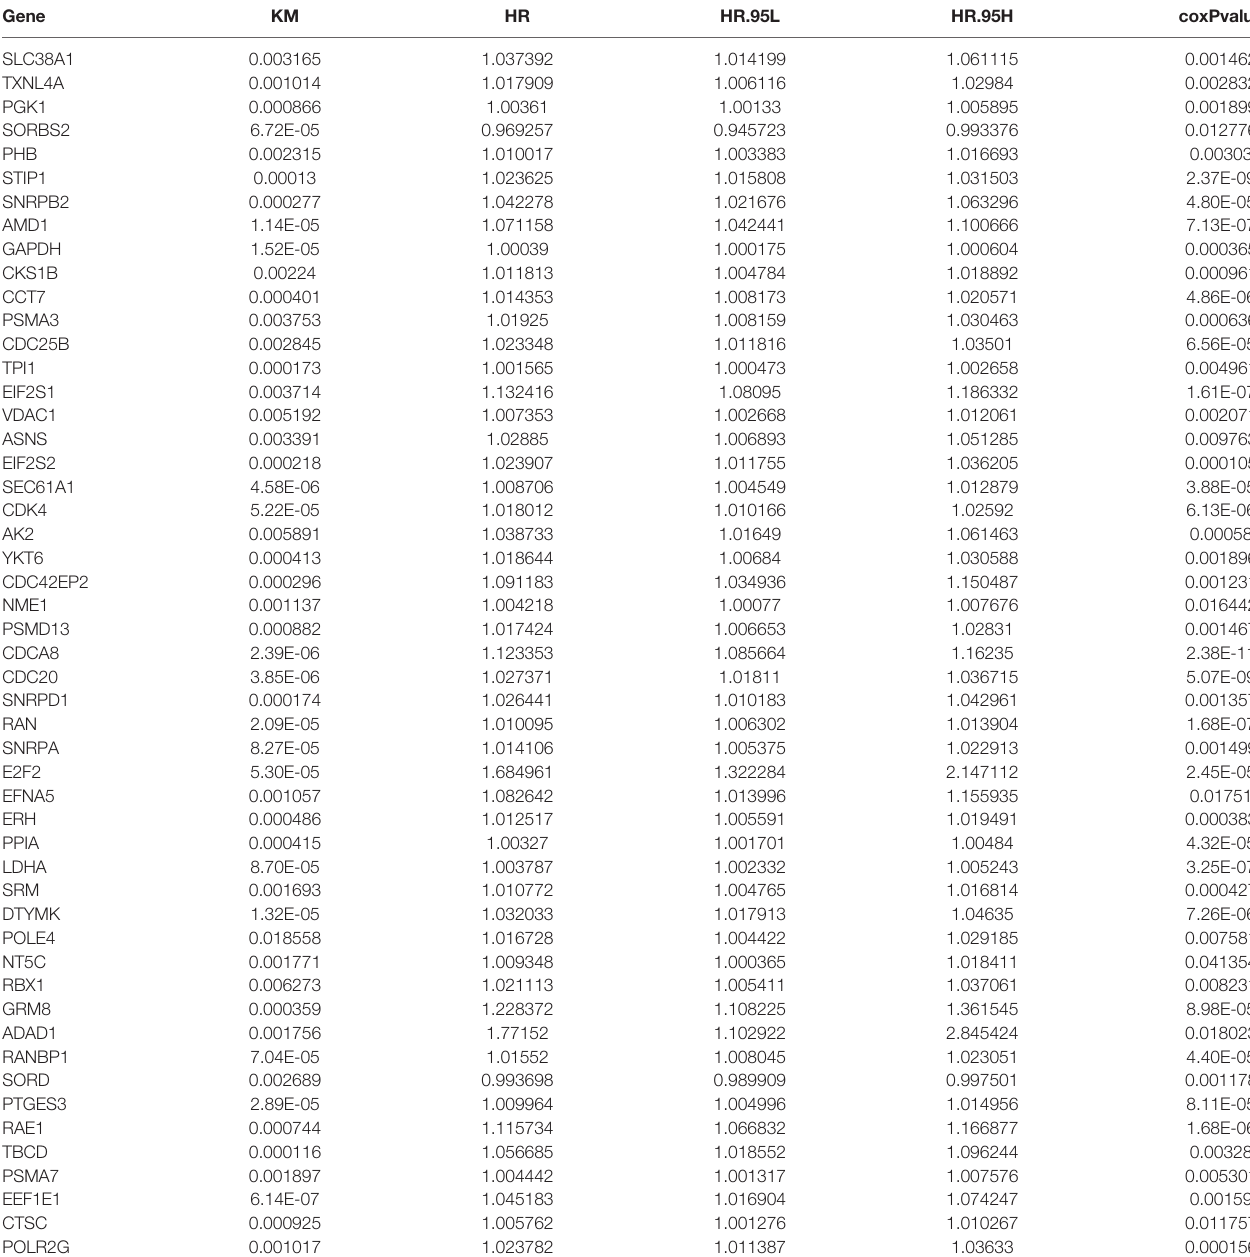
TABLE 3 | The prognostic related gene